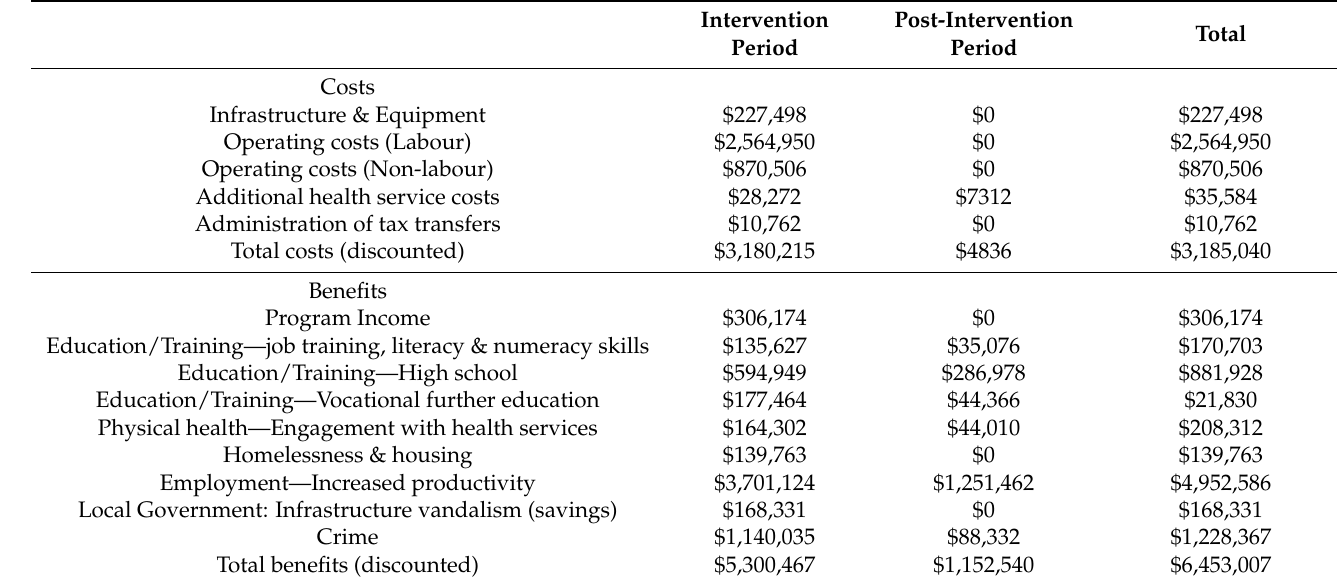
Table 1. Summary of costs and benefits, intervention, post-intervention and total.